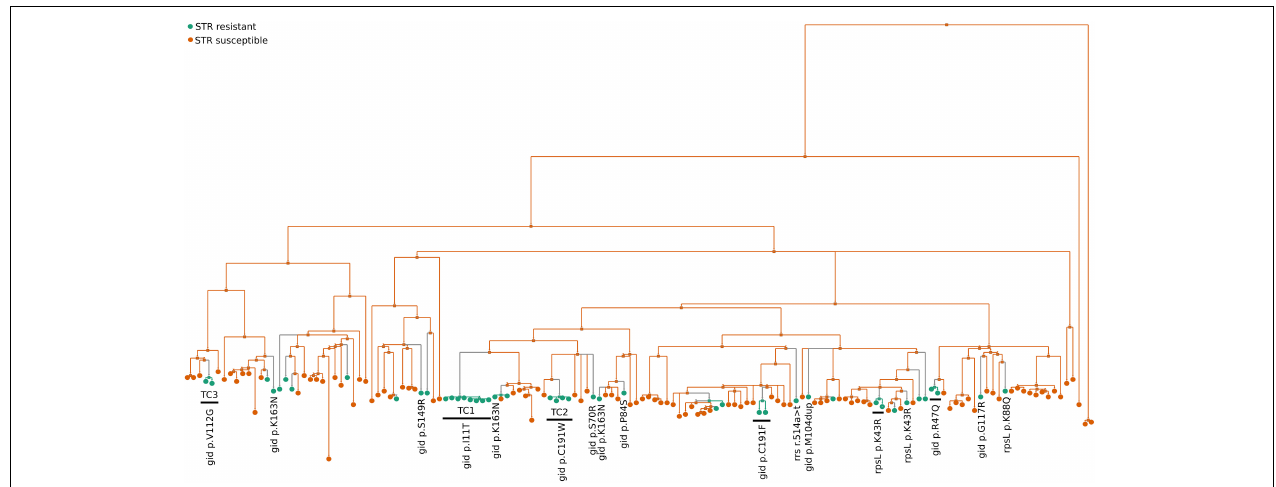
FIGURE 4 | Ancestral state reconstruction (ASR) of STR resistant M. tuberculosis isolates. ASR was done using log likelihood restricted maximum a posteriori (MAP) analysis of the phylogenetic tree with the binary classification of each sequence as STR resistant (green circles) or susceptible (orange circles) following the results from the phenotypic tests. Previously known rrs and rpsL STR resistance mutations ( rrs r.514a > t, rpsL p.Lys43Arg and p.Lys88Gln) and gid mutations ( gid p.Arg47Gln, p.Ser70Arg, p.Pro84Ser, p.Met104dup, p.Va1112Gly, p.Ser149Arg, p.Gly117Arg and p.Lys163Asn) that exclusively present in STR resistant isolates are